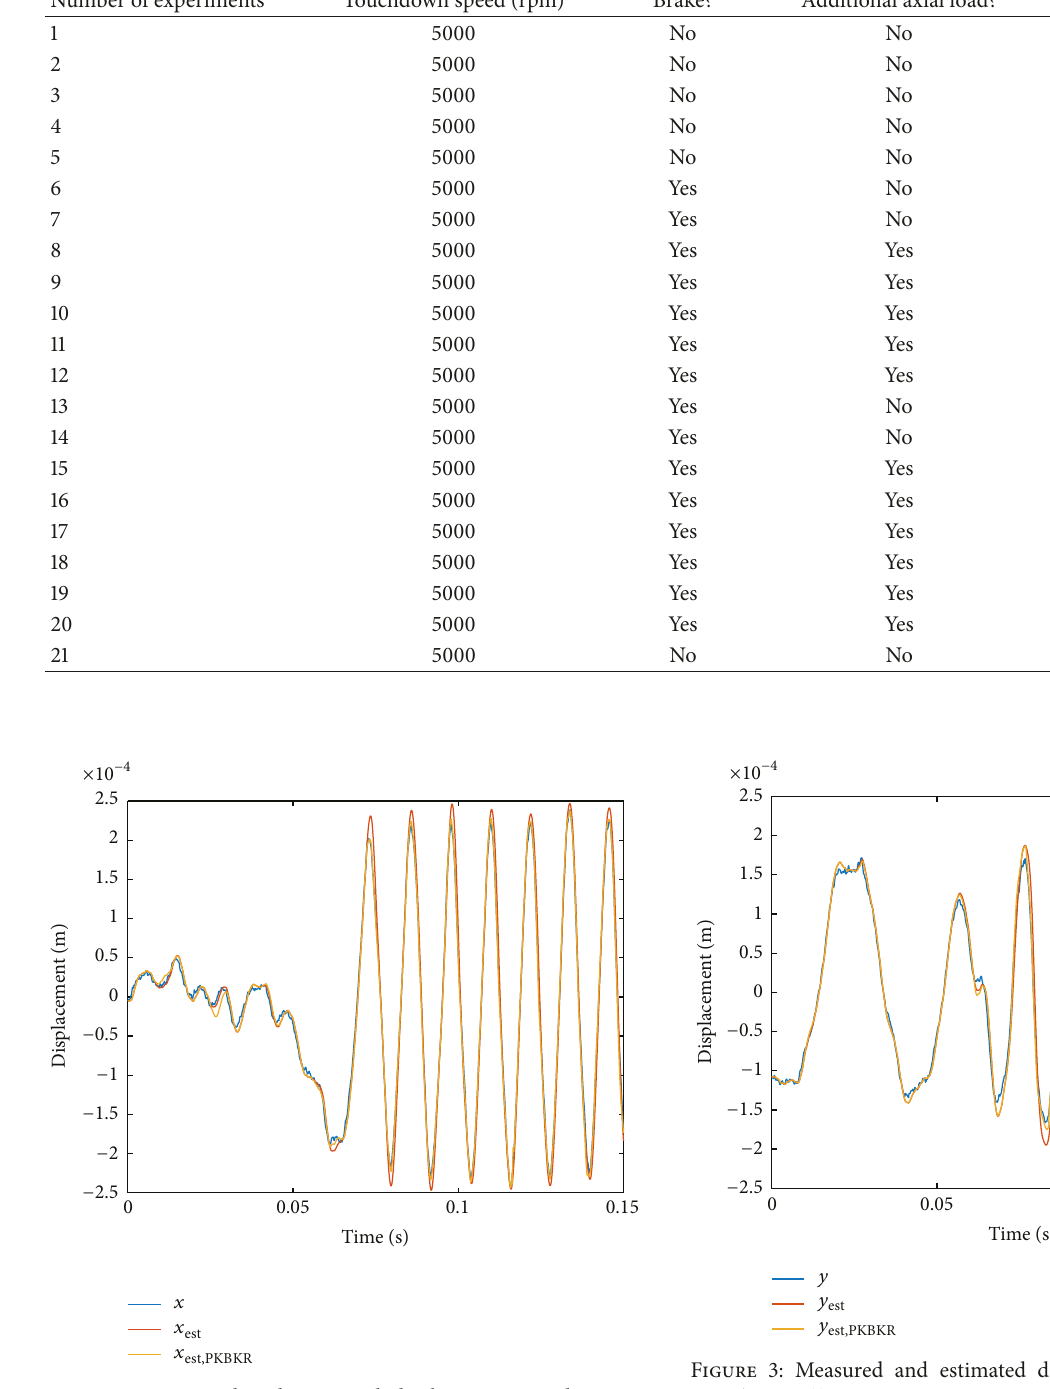
Figure 2: Measured and estimated displacements. X -direction, experiment #11.